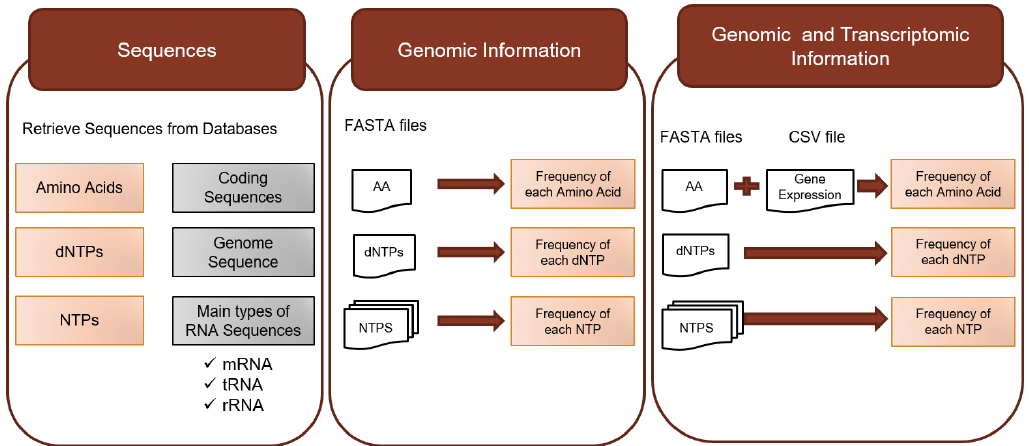
Figure 1: Process to determine the frequency of each monomer from genome and transcriptomic